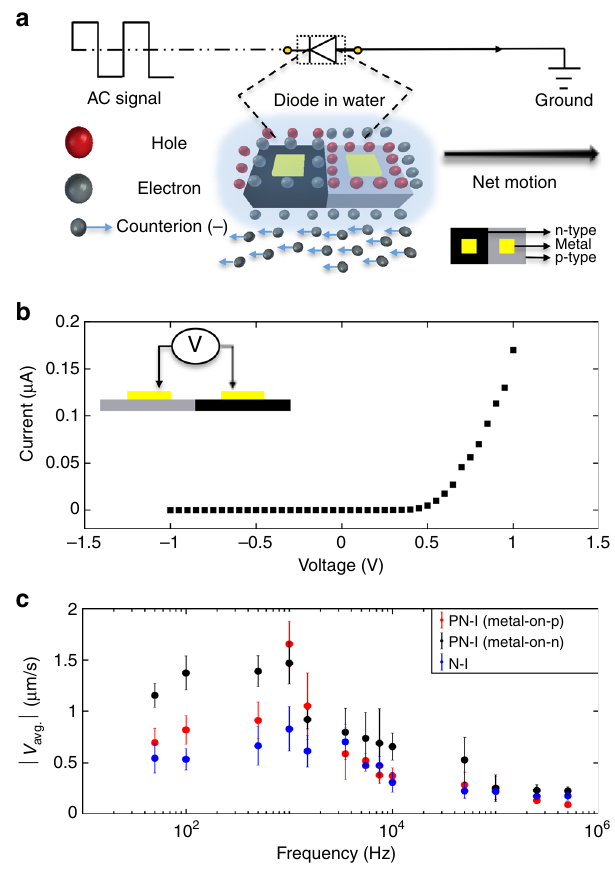
Fig. 5 Electrical propulsion and frequency analysis of p – n junction and p – n junction diode microparticles. a Electrical circuit diagram of a p – n junction diode microparticle (PN-II) suspended in water. An AC electric fi eld is applied to a fl uidic cell containing gold electrodes. Large red and grey spheres represent positively and negatively charged electronic carriers, respectively, which can diffuse across the diode microparticles; small gray spheres with blue arrows represent negative counterions in the fl uid. b Current – -voltage ( I – V ) characteristic curve of PN-II diode microparticles. The I – V curve was measured with a probe on each side of the p – n junction diode (inset). c Frequency analysis of the two types of PN-I microparticles (black and red for p – n junction microparticles with the metal contact on the n-side and p-side, respectively) in comparison to the N-I microparticles (blue). Data were collected at a fi xed E 2 = 54.4 kV 2 cm − 2 . Each data point represents the average and SD (one above and one below for the error bars), as measured from fi ve different microparticles in a single